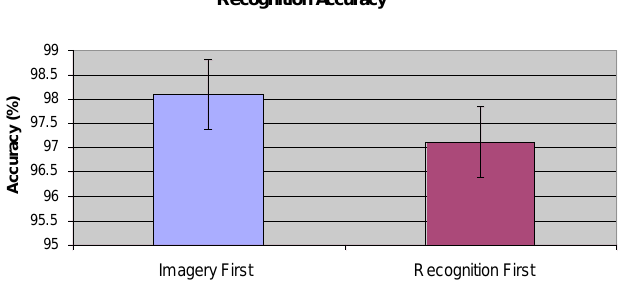
Figure 5: The mean recognition accuracies in the two Tasks. In The Imagery First group, participants attempted to visualize each picture immediately after viewing it, and in The Recognition First group they performed the imagery task after a recognition test.